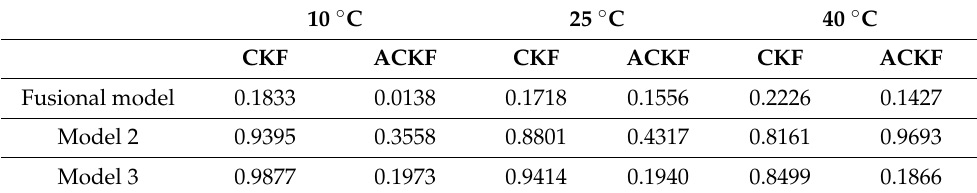
Table 9. RMSE of capacity estimation for NMC battery (Ah).